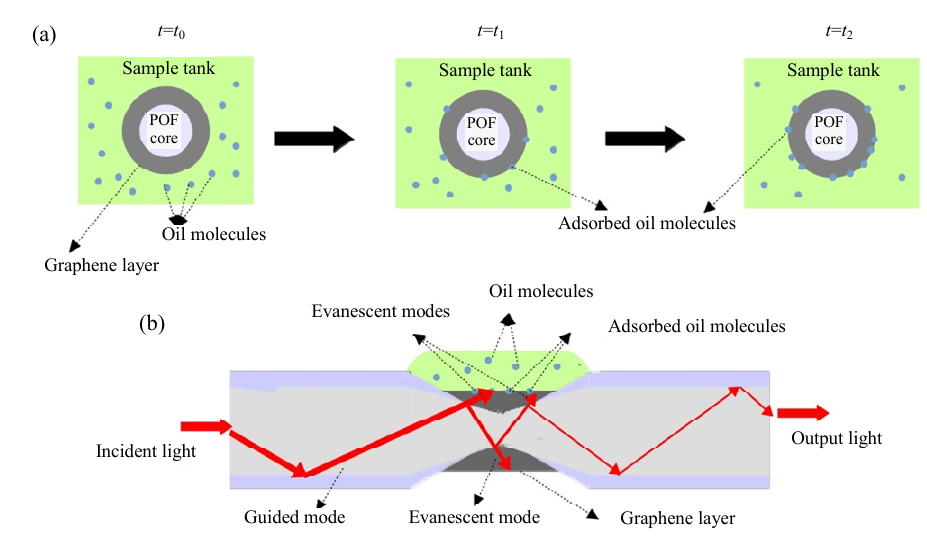
Fig. 6 Ilustration of (a) time evolution of oil molecules adsorption by the graphene layer on tapered POF and (b) schematic diagram of the mode propagation in the graphene-coated tapered POF.